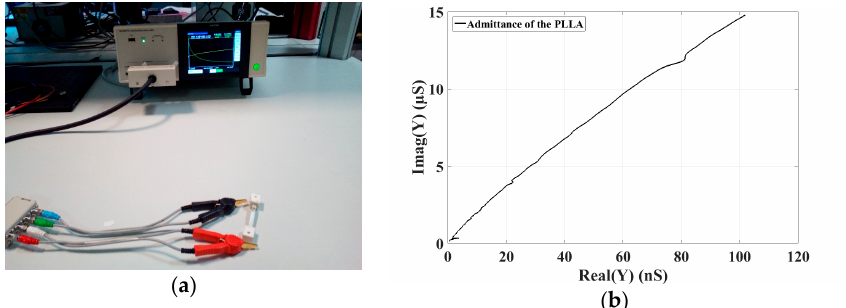
Figure 4. ( a ) Pictures of the impedance measurement with the HIOKI impedance-meter; ( b ) Nyquist representation of the admittance of the PLLA between 1 kHz and 100 kHz.